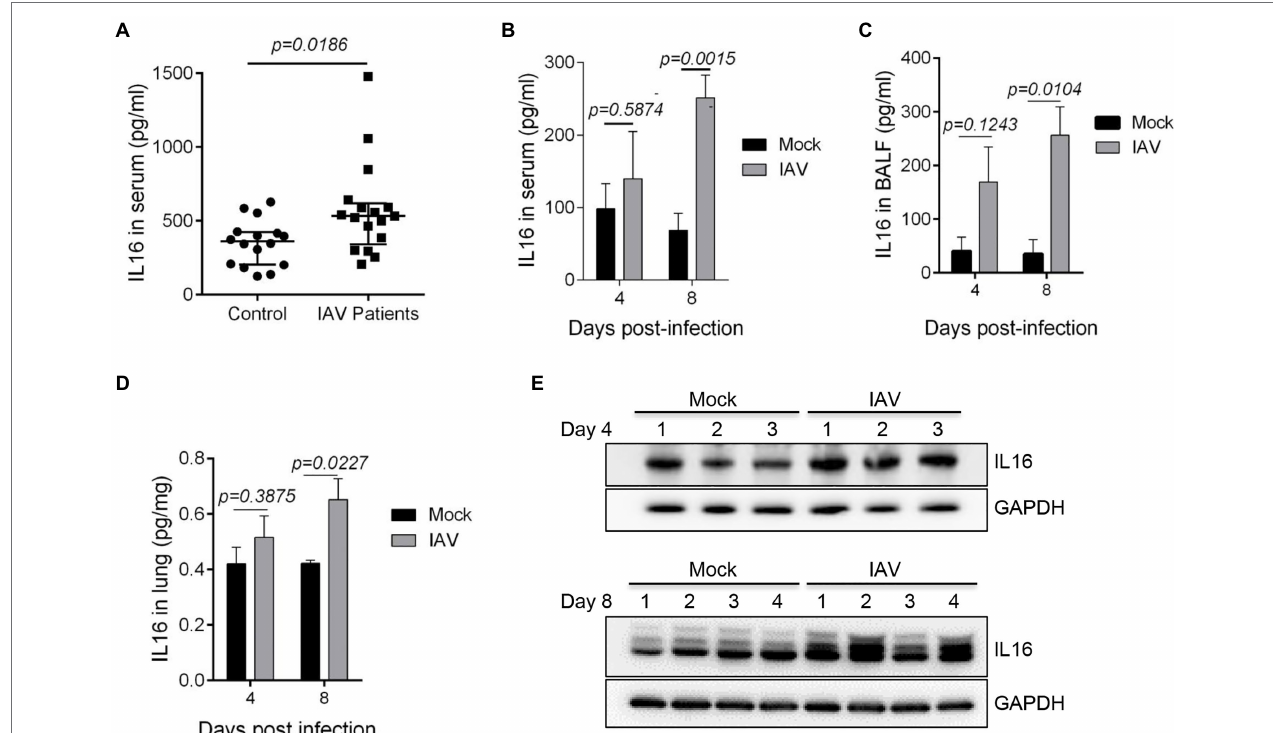
FIGURE 1 | The level of interleukin 16 (IL16) is increased in influenza A virus (IAV)-infected children and mice. (A) Sera from IAV-infected children ( n = 17) and healthy controls ( n = 18) were detected for IL16 by ELISA. (B–E) C57BL/6 WT mice (6–8 weeks) were infected with mock ( n = 5) or PR8 virus (8,000 PFU/mouse, n = 6). ELISA was performed to detect the level of IL16 in serum samples (B) , bronchoalveolar lavage fluid (BALF; C ), and lung homogenates (D) from IAV-infected mice and control mice at day 4 and day 8 post-infection. The lung homogenates were also subjected to immunoblot analyses for IL16 detection on day 4 and day 8 post-infection, number 1–4 represents individual mouse (E) . A value of p < 0.05 was considered